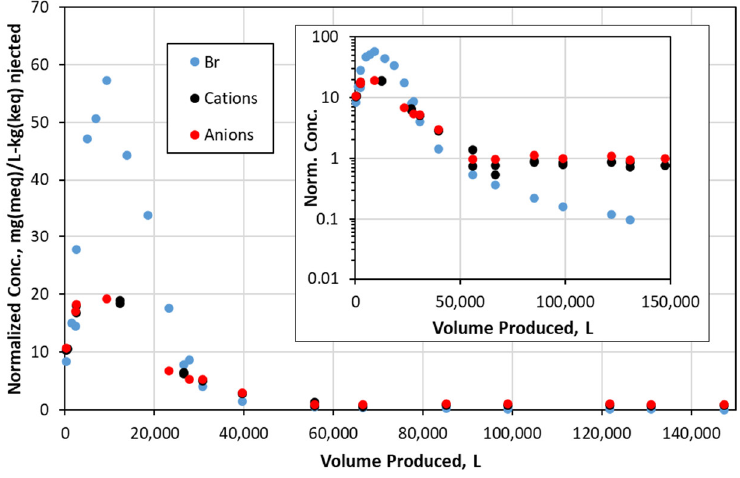
Figure A17. Normalized concentrations of bromide, cation charge, and anion charge as a function of volume produced in the dithionite push-pull test in well 15P-315. Inset plot shows log concentrations.